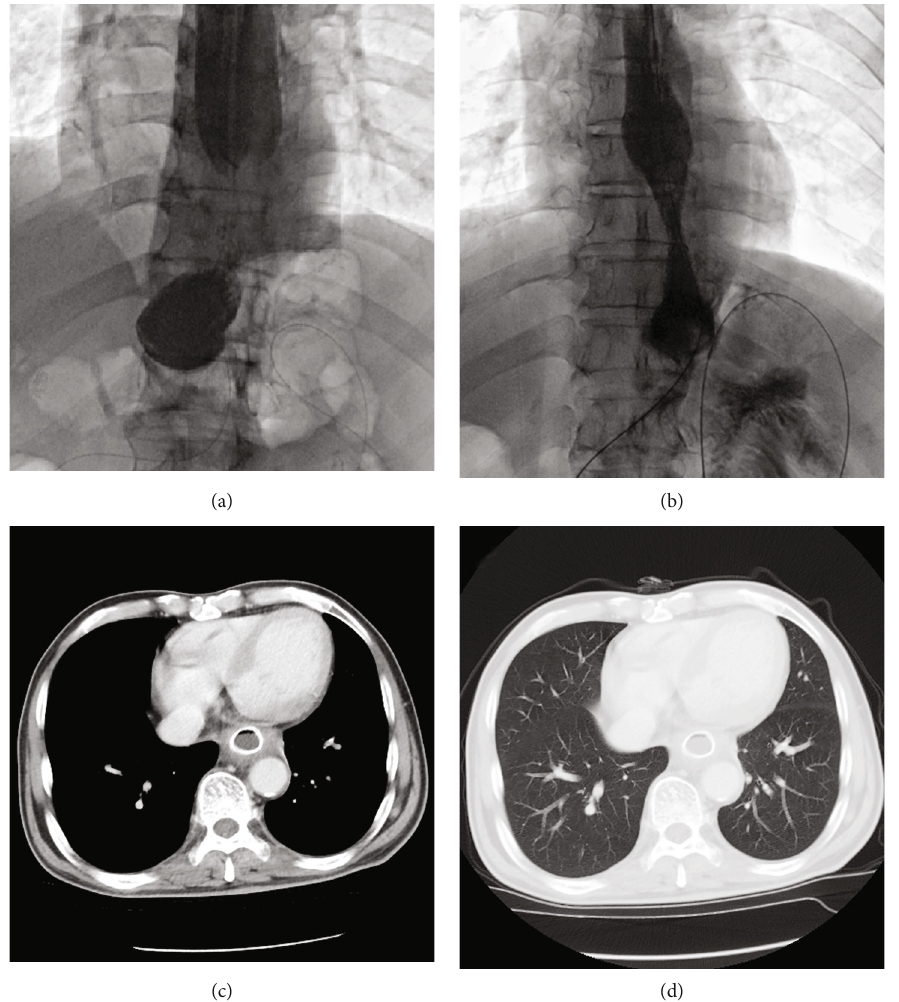
Figure 3: A 63-year-old man with anastomotic stenosis treated by stent placement (case 12). (a) Esophagography showed the site of anastomotic stenosis in the lower esophagus. (b) A covered stent was inserted. (c, d) At 48 days after stent placement, a chest CT scan shows well expansion of stent and relief of